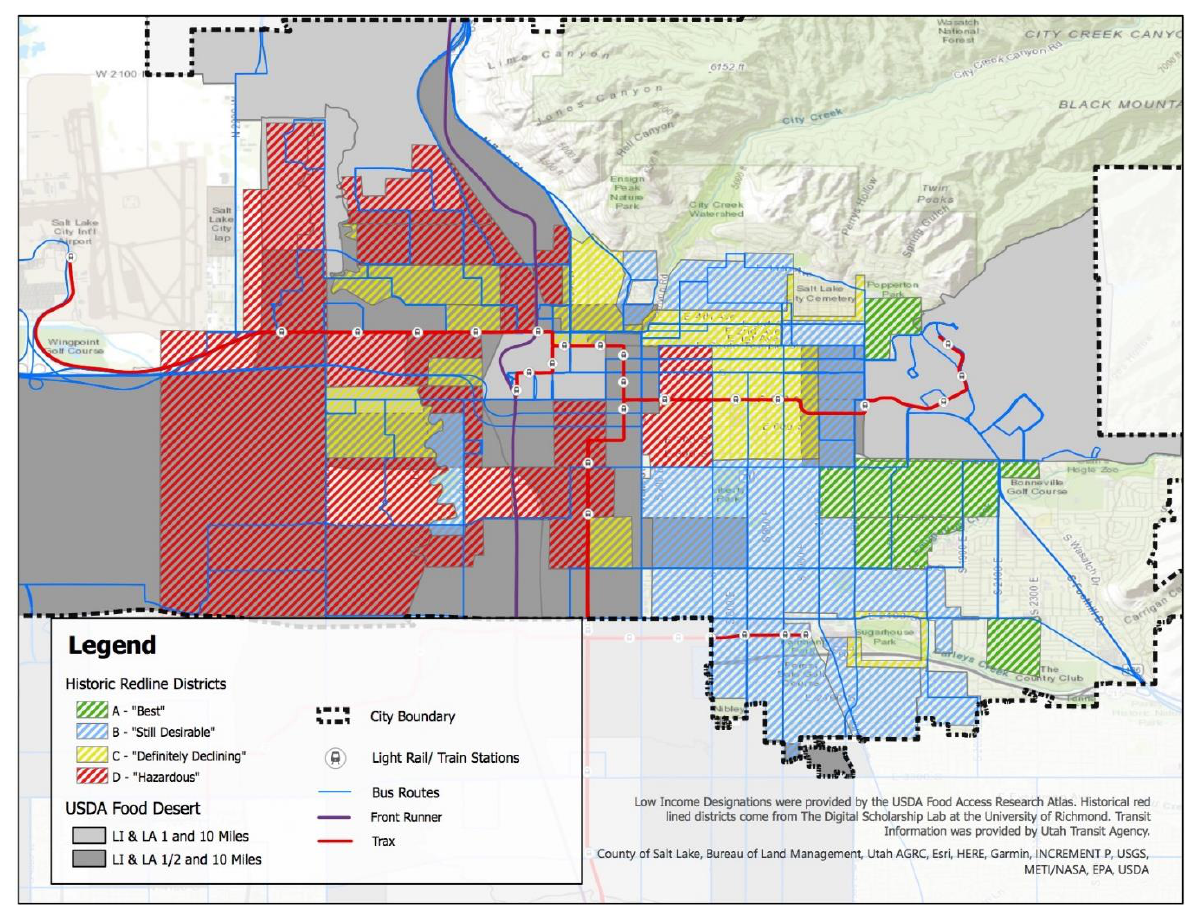
Figure 3. U.S. Department of Agriculture (USDA) Food Deserts and Homeowners Loan Corporation (HOLC) Redlining